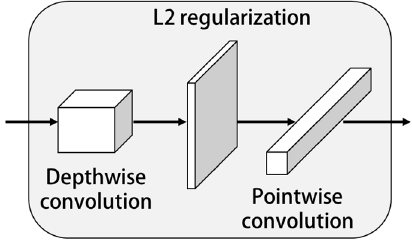
Figure 3. Regularization strategy to prevent over fitting.